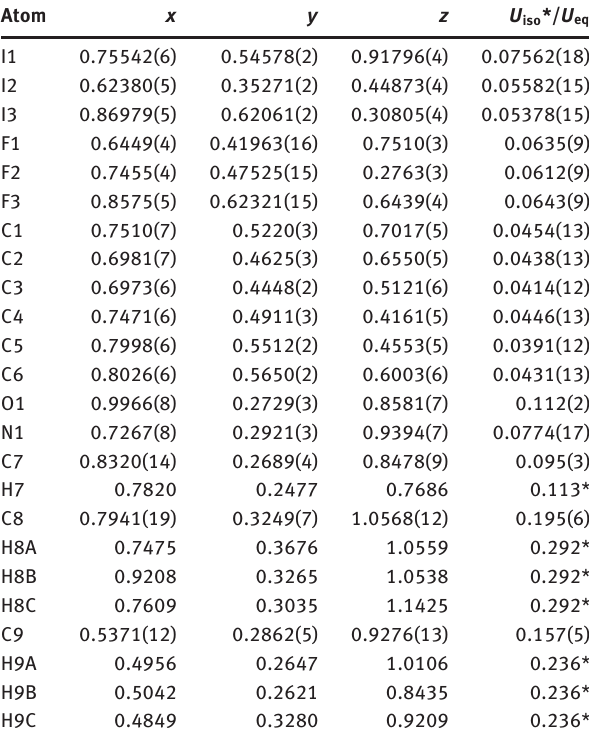
Table 2: Fractional atomic coordinates and isotropic or equivalent isotropic displacement parameters (Å 2